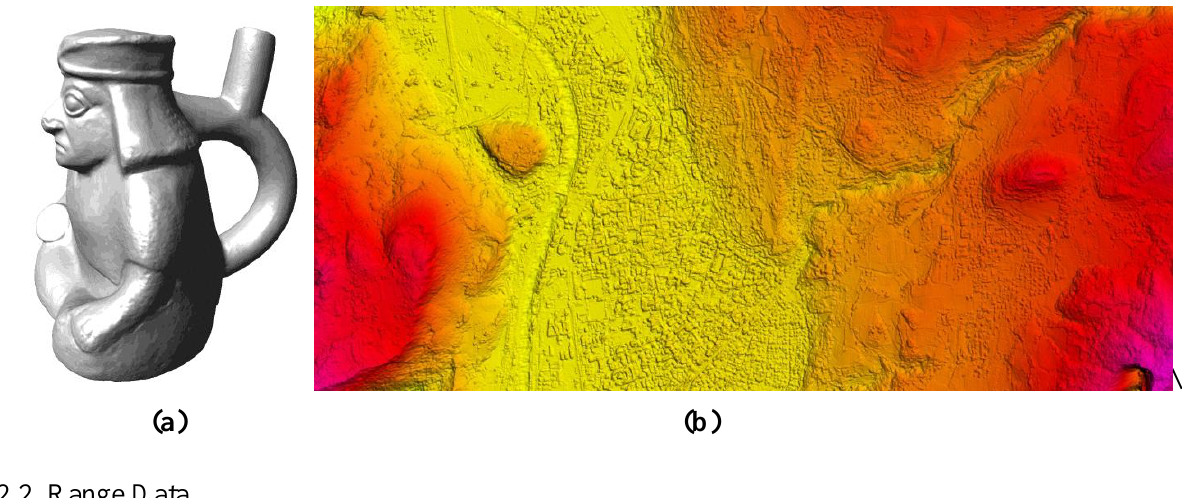
Figure 9. Automated 3D reconstruction with dense image matching: a small free-form object modeled from terrestrial images (a) and a landscape modeled using a WorldView-2 stereo-pair (b)